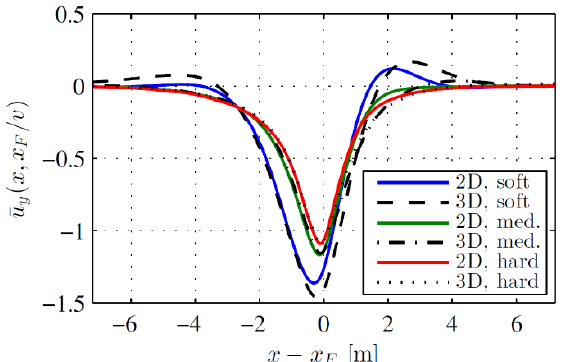
Figure 6. Normalized vertical displacement of the rail for the 3D FE model and the DSM for v = 100 m/s, h b = 0.6 m, h s = 6 m and different combinations of E b and E s ; x F is the point of load application.